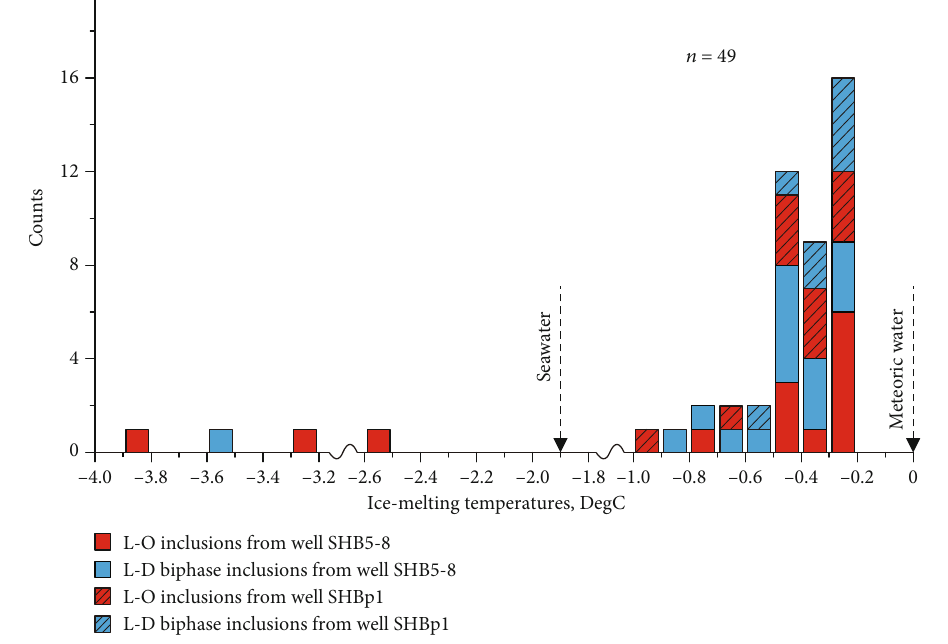
) and homogenization temperatures ( T m − ice